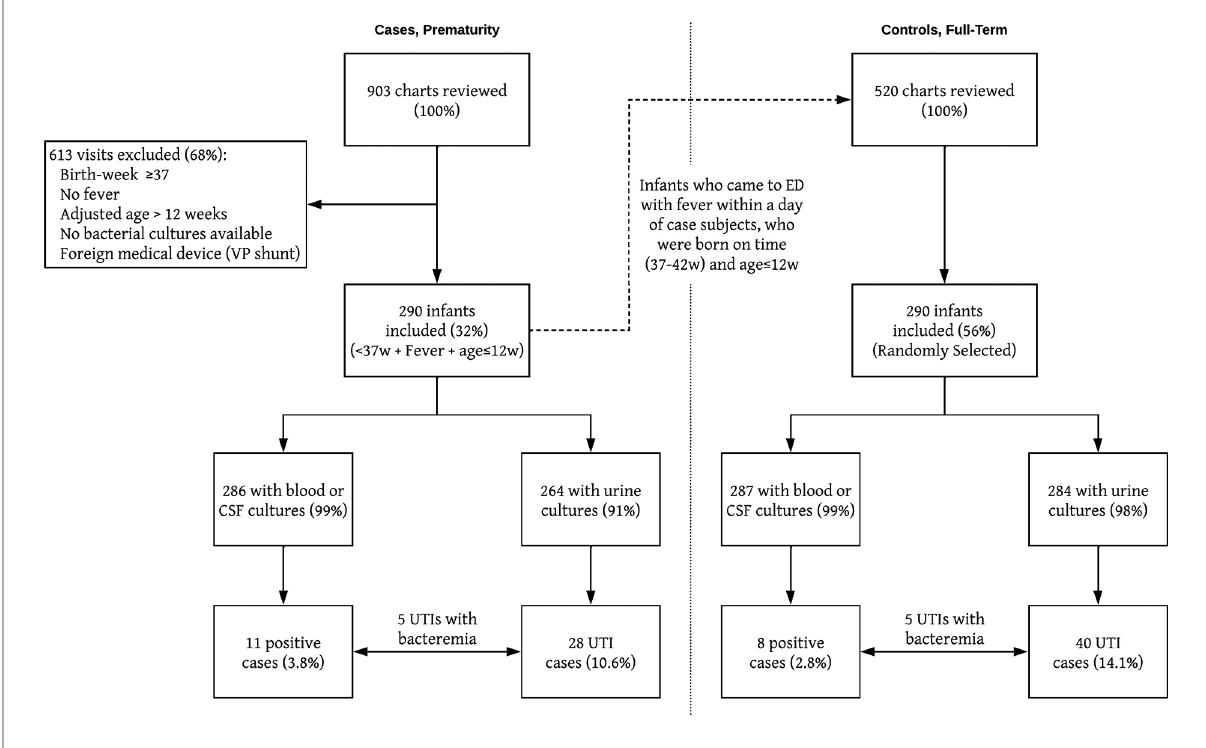
FIGURE 1 Flow-chart diagram of study design, data availability and culture